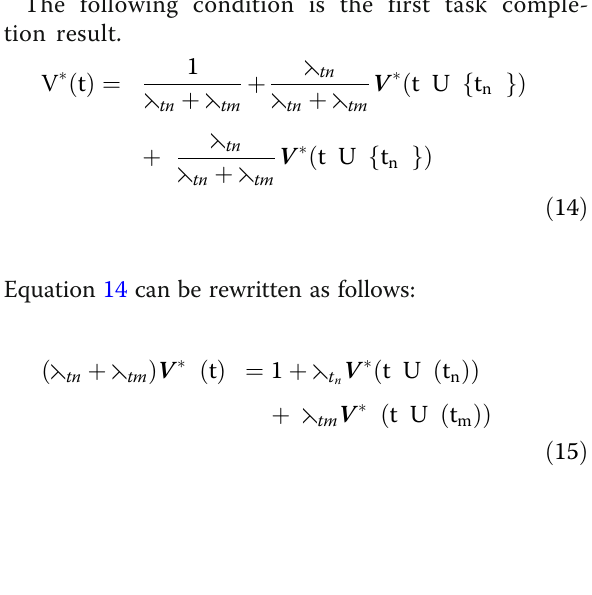
Table 16 Comparison of the proposed heuristic approach with the BATS and IDEA frameworks in term of TAT in ms BATS with 20 VMs IDEA with 20 VMs Heuristic approach with 20